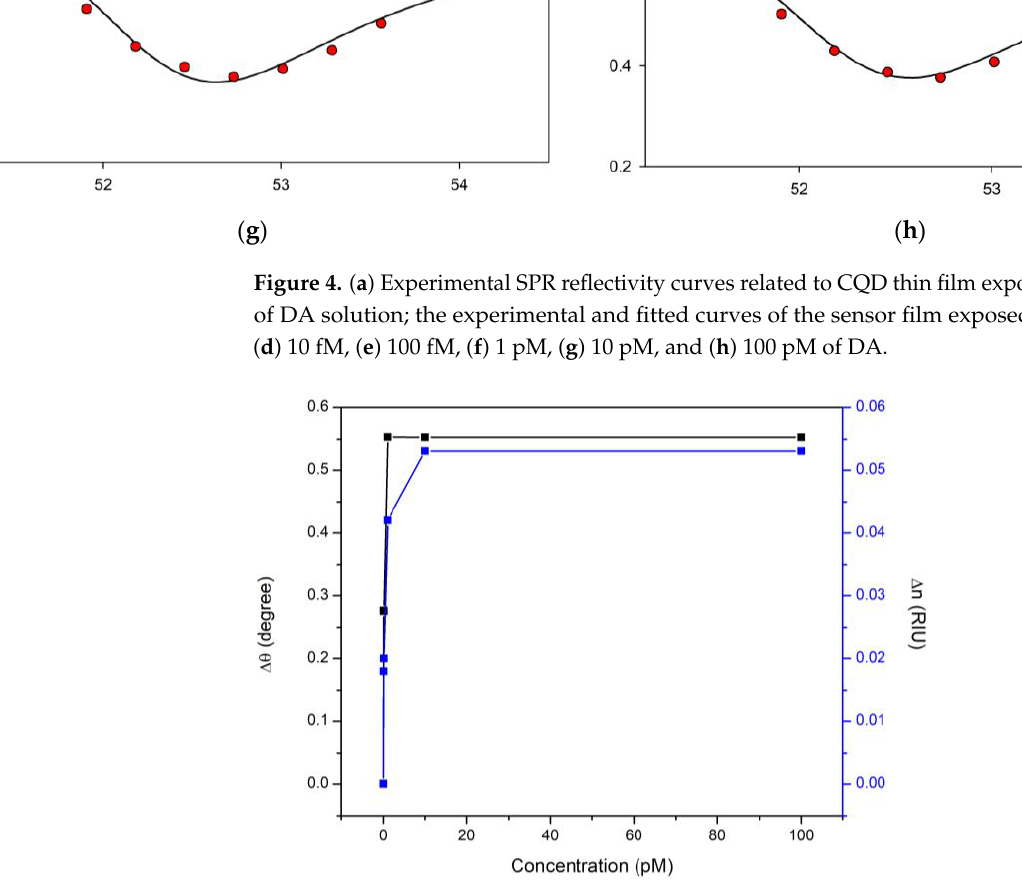
Figure 4. ( a ) Experimental SPR reflectivity curves related to CQD thin film exposed to different levels of DA solution; the experimental and fitted curves of the sensor film exposed to ( b ) 0 fM, ( c ) 1 fM, ( d ) 10 fM, ( e ) 100 fM, ( f ) 1 pM, ( g ) 10 pM, and ( h ) 100 pM of DA.